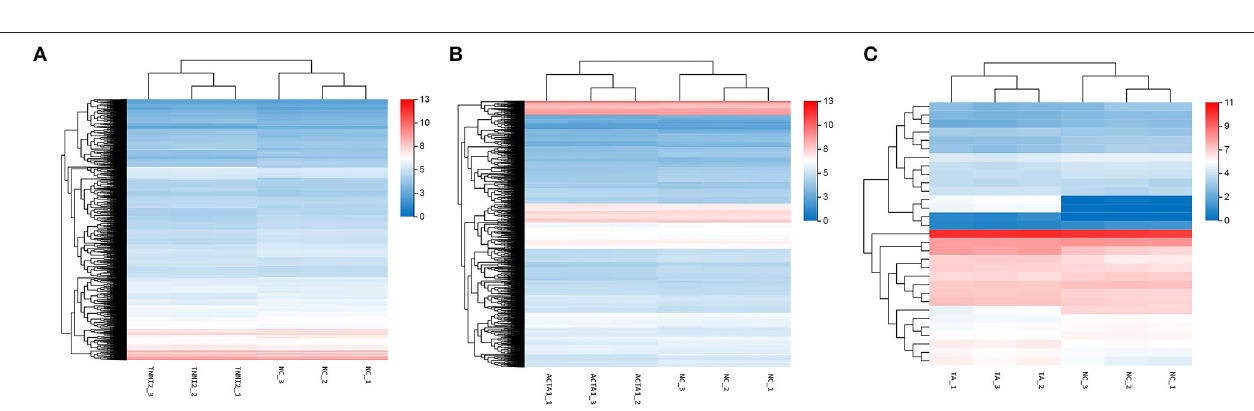
FIGURE 6 | Real-time PCR validation of the DEGs analyzed by RNA-seq. The x -axis represents genes. The y -axis shows the relative expression levels. (A) Seven genes that were identified as DEGs in group TNNI2. (B) Five genes that were identified as DEGs in group ACTA1. (C) Six genes that were identified as DEGs in group TNNI2-ACTA1 V1.